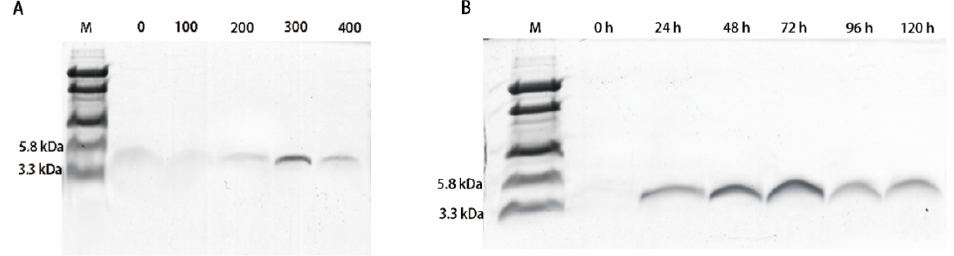
Figure 1. Tricine-SDS-PAGE of EF-1, ( A ) Tricine-SDS-PAGE of the purified secreted recombinant hybrid peptide EF-1 after 72 h methanol induction; lane M, mass weight markers; lane 2–6, purified EF-1 eluted with different concentrations of imidazole and in lane ~5 kDa (300 and 400 mM imidazole). ( B ) Tricine-SDS-PAGE of cell culture media after purified form expression; lane M, mass weight markers, lane 2–7, peptide expression after methanol (0–120 h) induction.